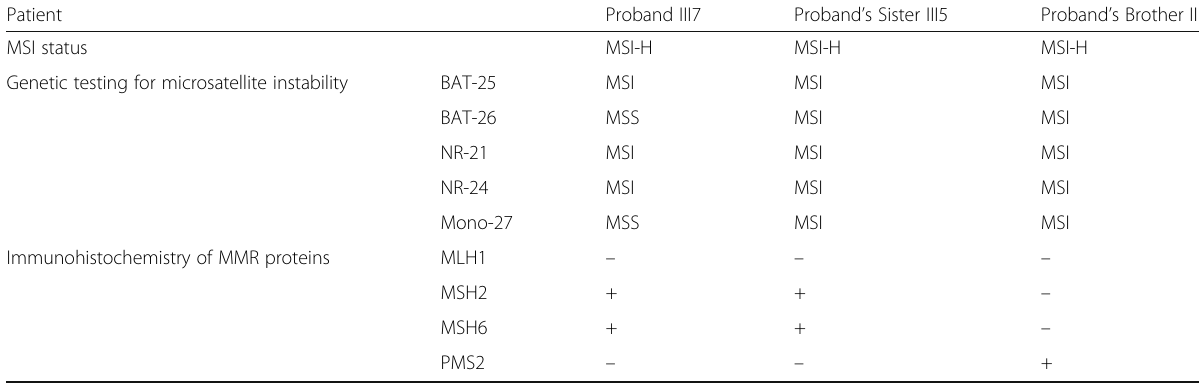
Table 2 Detection of microsatellite